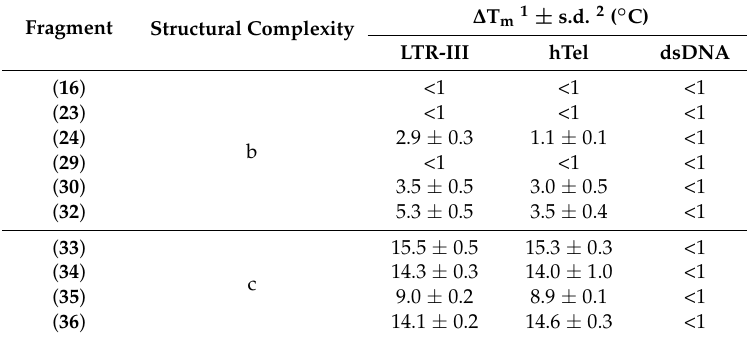
Table 2. Stabilization of LTR-III, hTel G4s and dsDNA (0.25 µ M) in the presence of 100-fold excess